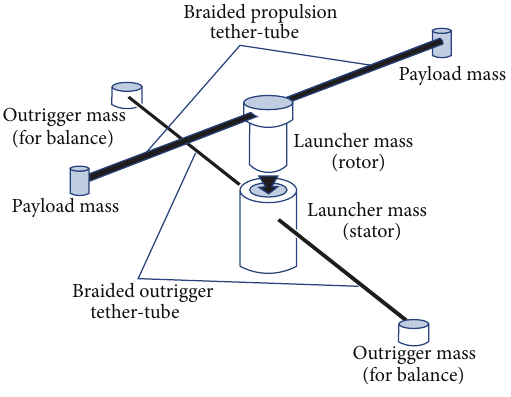
Figure 1: Schematic of a MMET and its components [9].